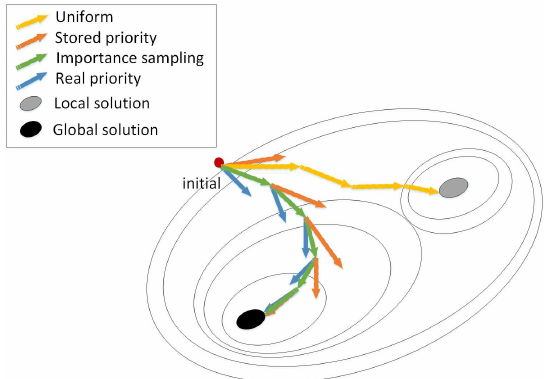
Figure 5. The convergence of uniform sampling, PER based on store priority, PER based on real priority, and PER with importance sampling in the training process, respectively. The contour lines constitute the space curve formed by the Q loss of all experiences.